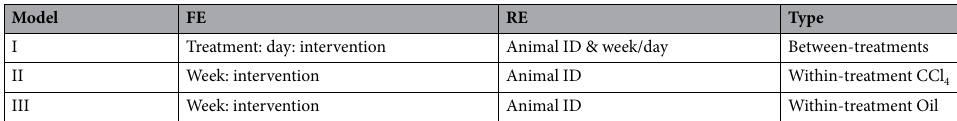
Table 2. Overview of the regression models with Fixed Effects (FE) and Random Effects (RE) parameters.